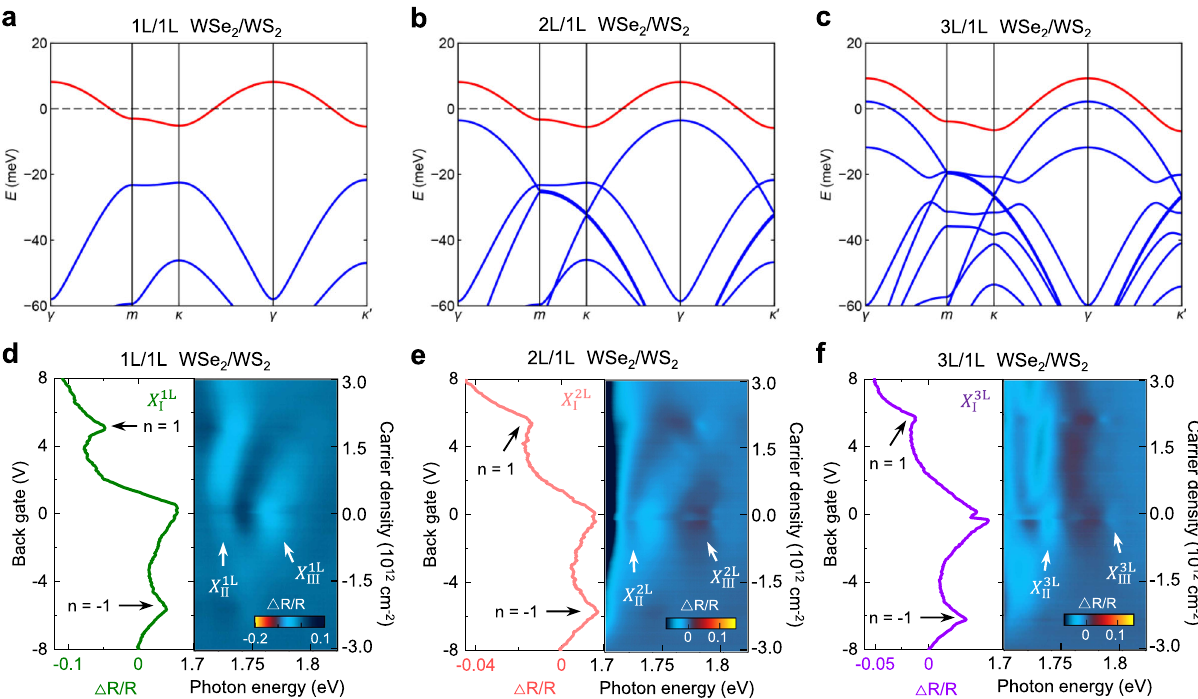
Fig. 3 | Layer dependence of the electronic fl at miniband for WSe 2 /WS 2 moiré superlattices. a – c are calculated electronic bandstructure of the valence band in 1L/1L WSe 2 /WS 2 , 2L/1L WSe 2 /WS 2 , 3L/1L WSe 2 /WS 2 , respectively (details in Sup- plementary Information Note 3), with the moiré fl at band from the 1st layer WSe 2